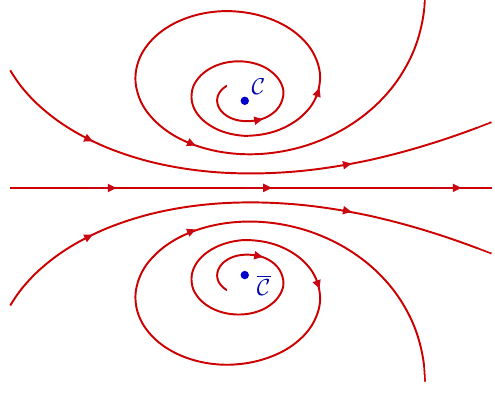
Figure 11: RG flow topology expected in the complexified Potts model at Q >